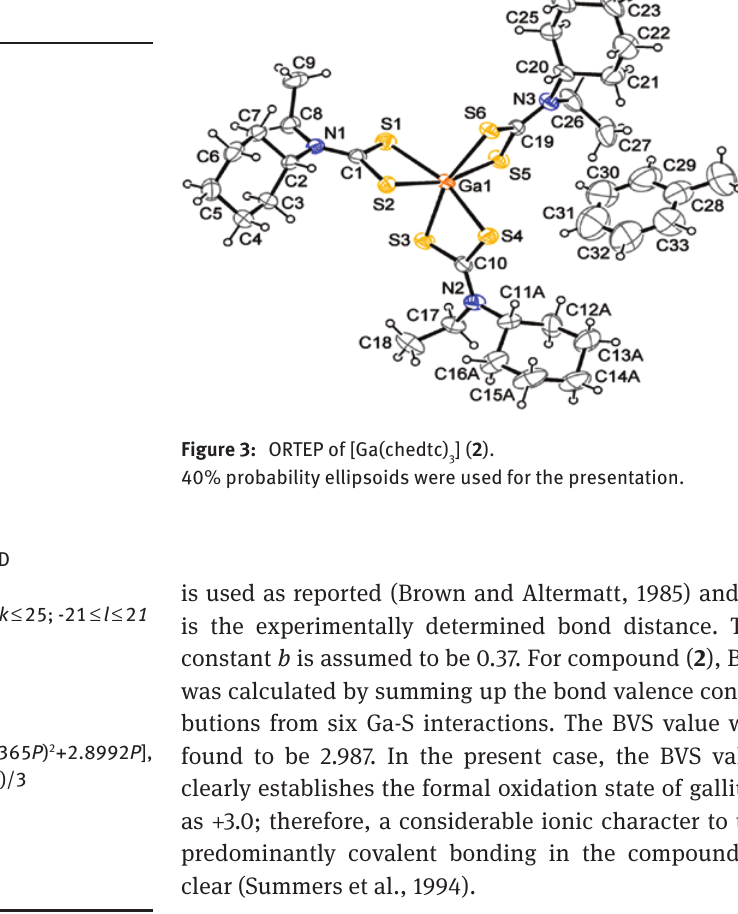
Table 1: Crystal data, data collection, and refinement parameters for [Ga(chedtc) ] ( 2 ). 3